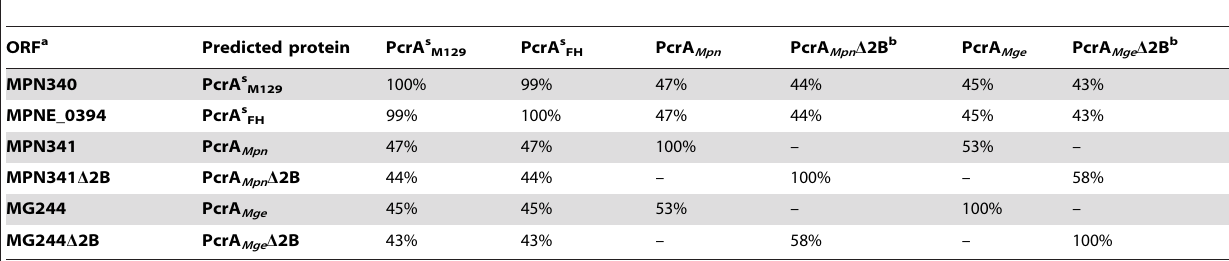
Table 1. Amino acid sequence similarities (% identity) between the PcrA-like helicases from M. pneumoniae and M. genitalium.